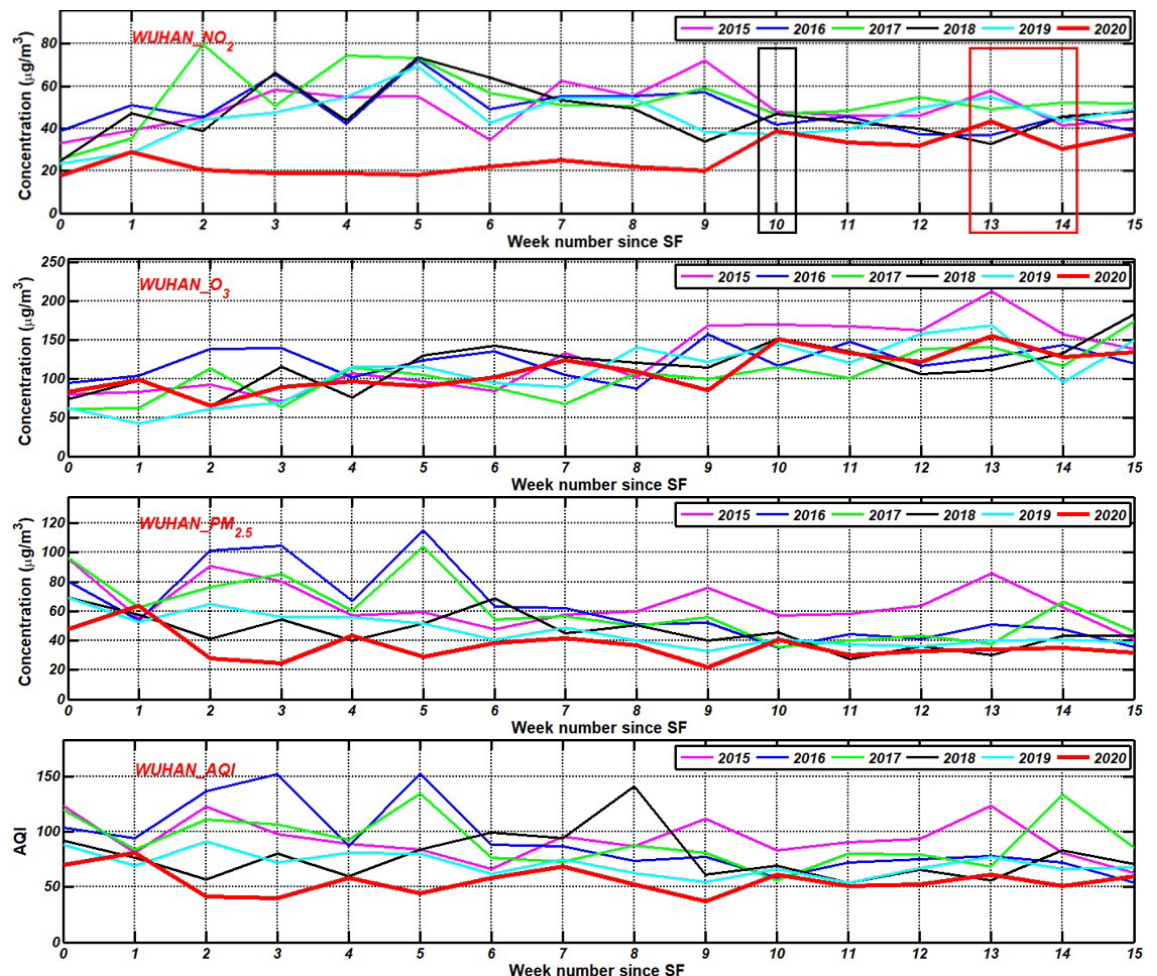
Figure 7. As Fig. 6 but for